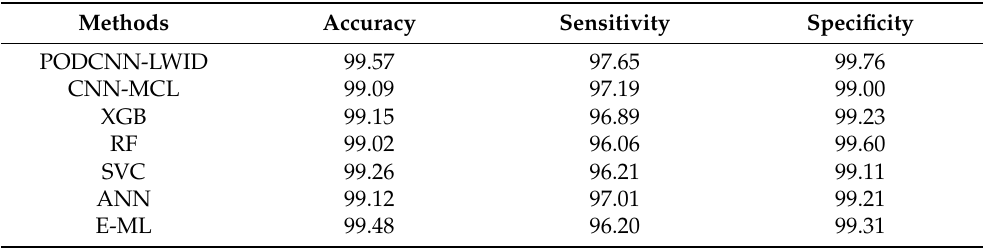
Table 5. Comparative analysis of PODCNN-LWID approach with existing algorithms.